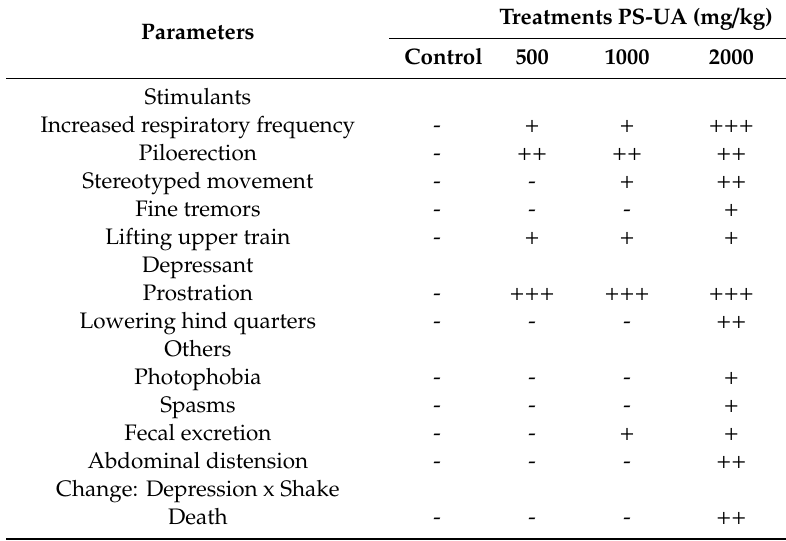
Others Photophobia